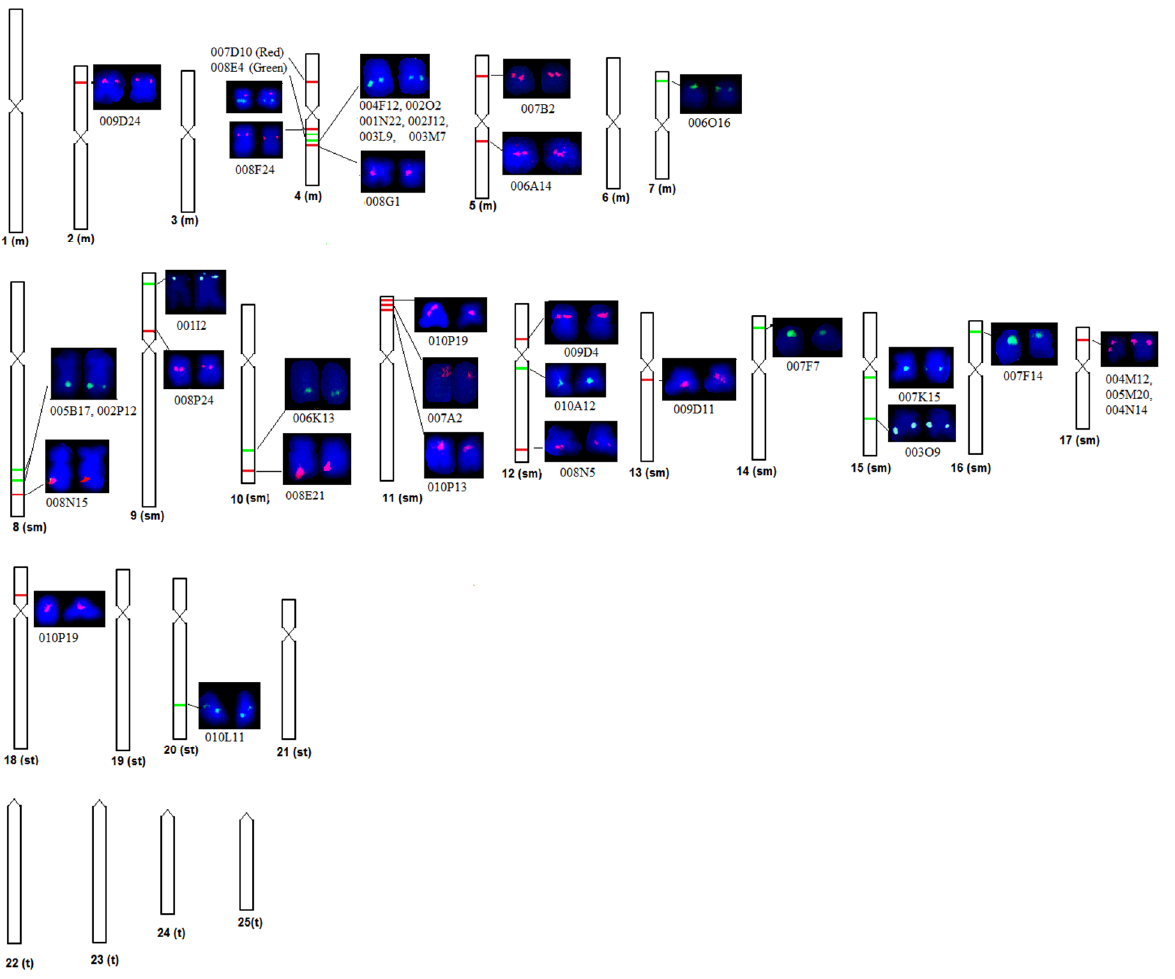
Figure 1. BAC-FISH of 36 clones on metaphase chromosomes of Clarias magur. Signal with red colour was DNA probe labelled with Tetramethyl rhodamine-5 dUTP and green colour labelled with Flourescien-12 dUTP. Signals with clone ID represent the physical location of BAC in the corresponding region of magur chromosomes.